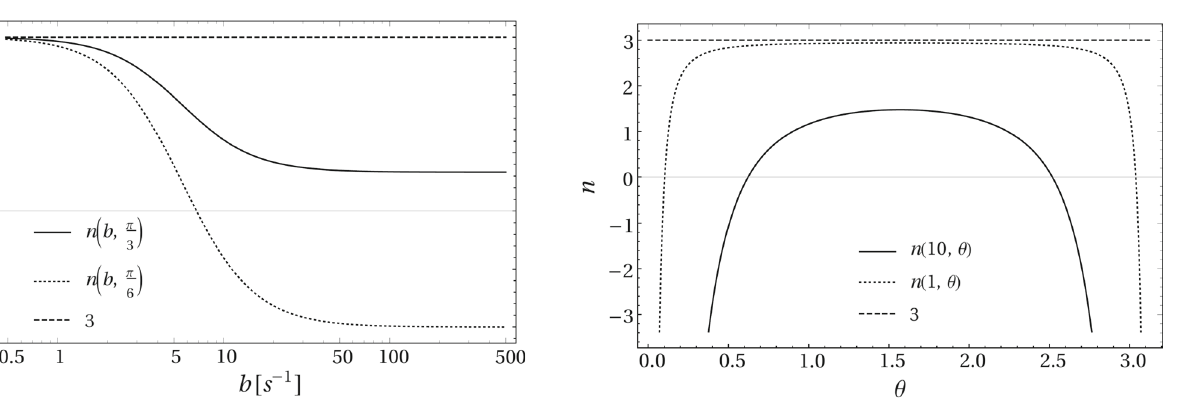
Fig. 2 The braking indices are functions of accelerations of pulsars for fixed magnetic inclination angle. The accelerations of pulsars are parallel to direction of rotation axes